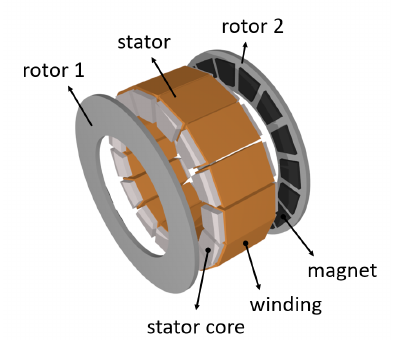
Figure 1. Axial flux permanent magnet synchronous machine (AFPMSM) with yokeless and segmented armature (YASA)